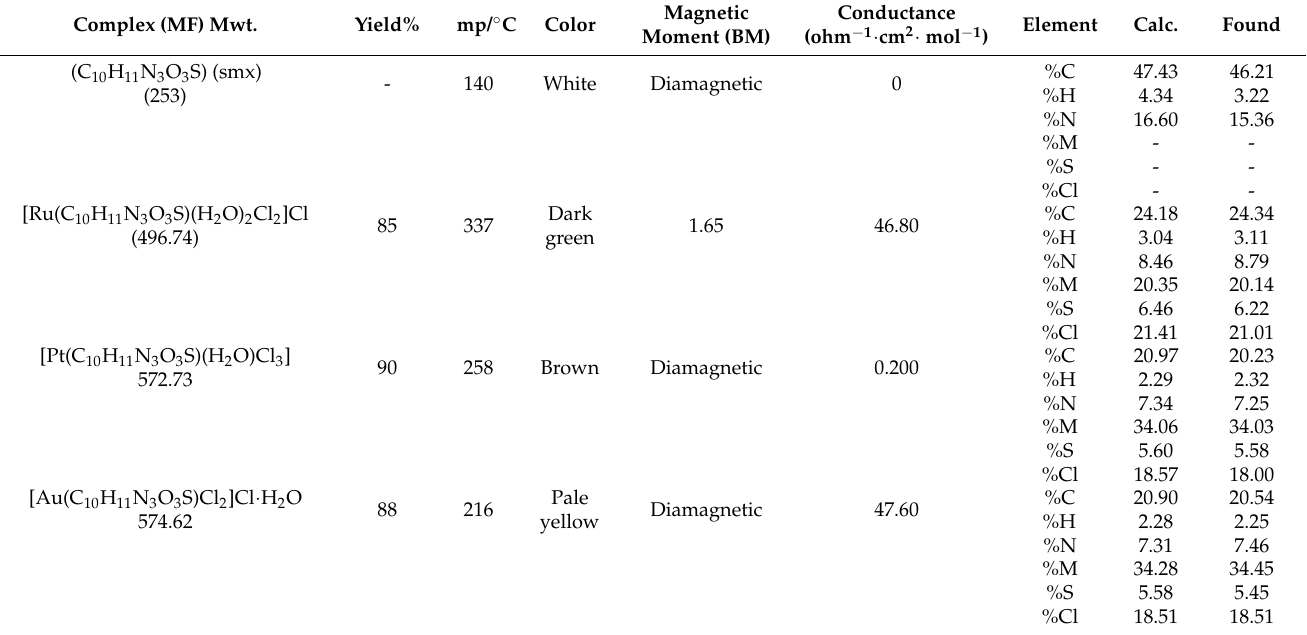
Table 2. Physico-analytical and elemental analysis data for sulfamethoxazole and its metal complexes. Complex (MF)